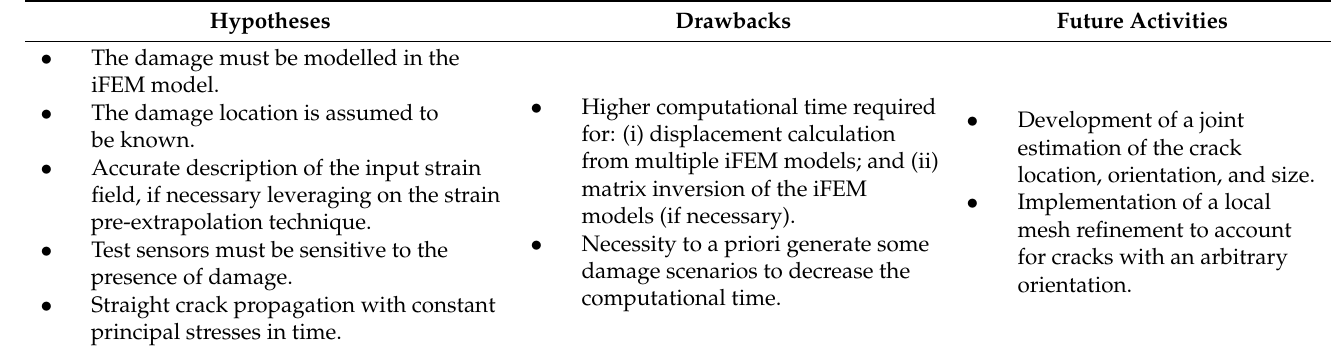
Table 2. Main hypotheses and drawbacks of the iFEM model updating procedure proposed for crack size estimation, together with future developments to meet some